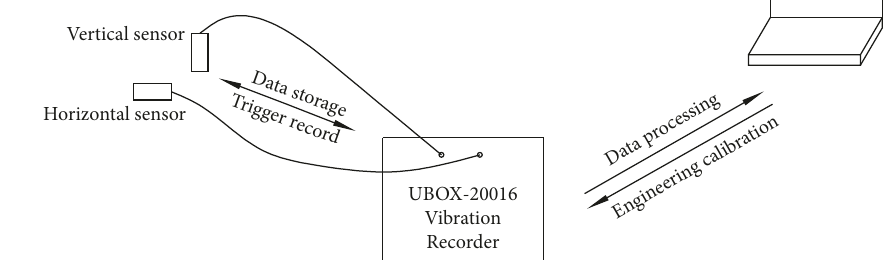
Figure 2: Layout of blasting holes.